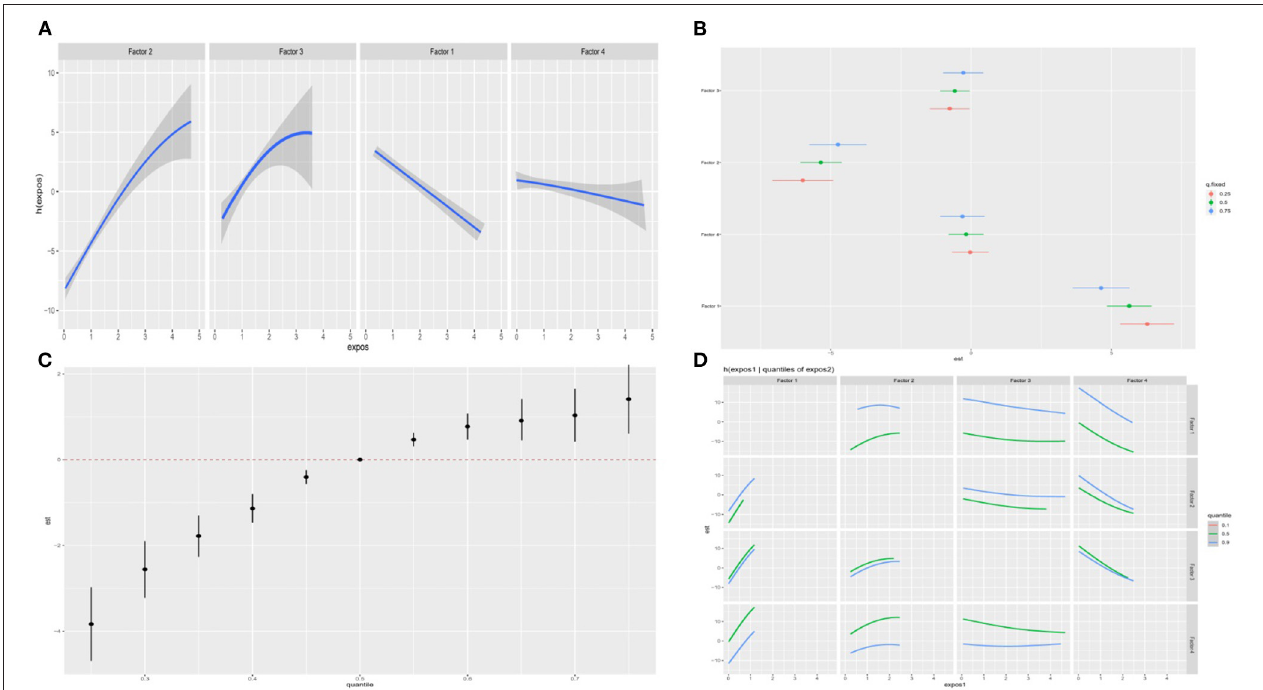
FIGURE 4 | The BKMR model is used to study the association between dietary patterns among men and depression in the elderly. The model is based on age, gender, education level, employment status, smoking status, drinking status, daily energy intake, hypertension and diabetes, and dietary patterns. (A) The single dietary pattern effect (estimates and 95% credible intervals). (B) The univariate nutrient response function of each dietary pattern has a 95% confidence band, and the other nutrients are fixed at the median. (C) Cumulative effects of dietary patterns (estimated value and 95% confidence interval). Compared with other nutrients in the 50th percentile, the nutrients are in a specific percentile (X-axis). (D) Bivariate exposure response function of each two dietary patterns in